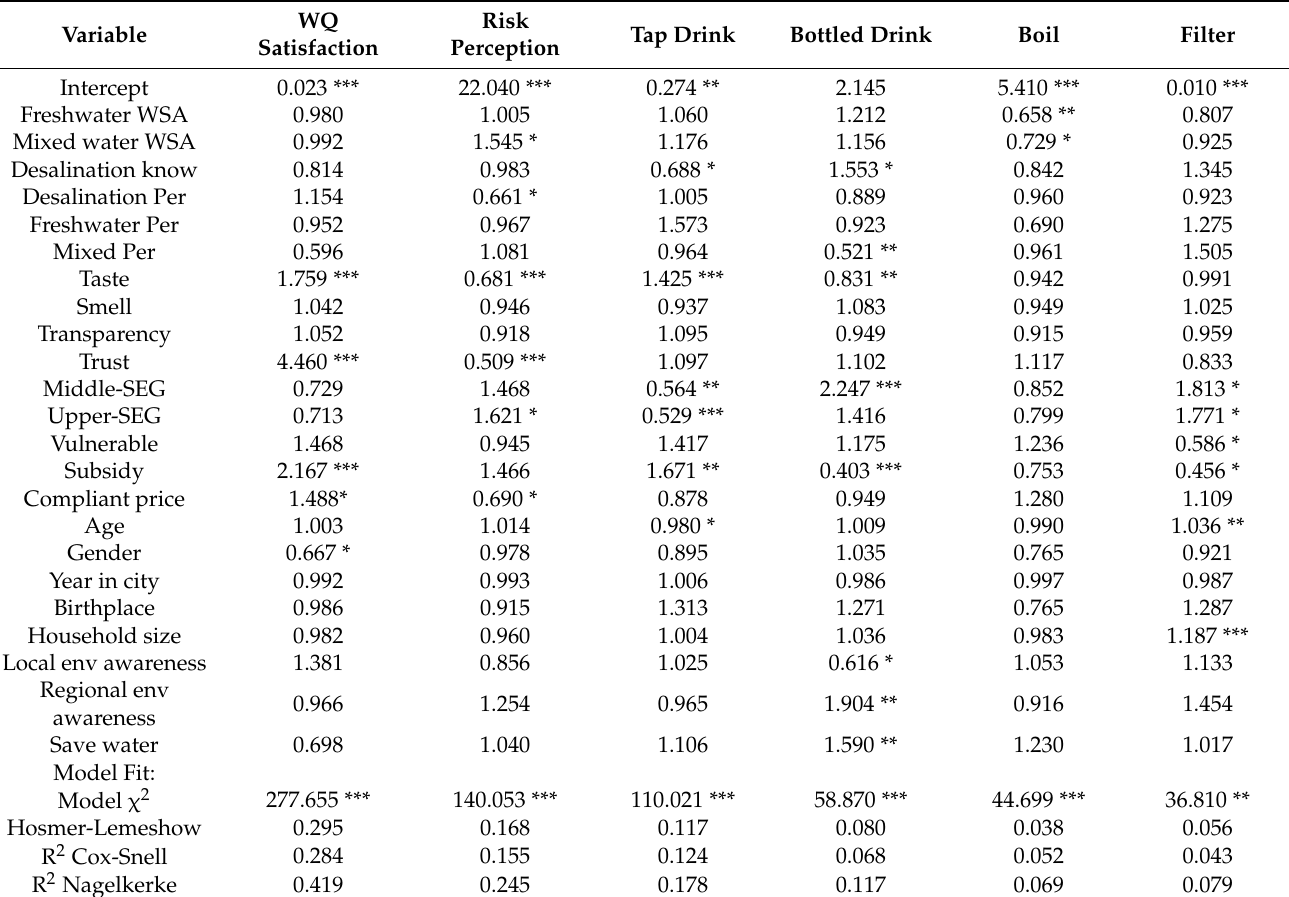
Table 2. Odds ratio and goodness-of-fit for each Binary Logit